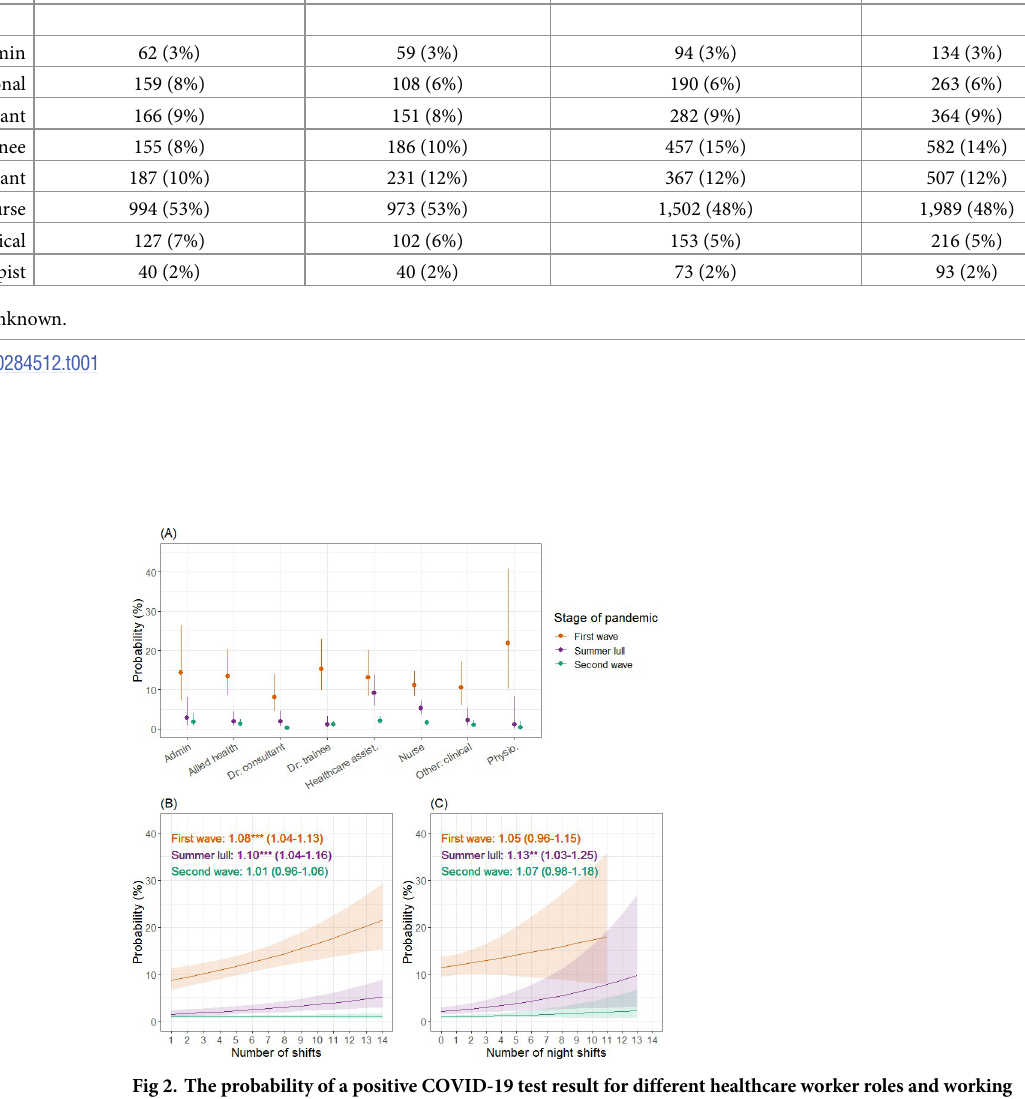
Fig 2. The probability of a positive COVID-19 test result for different healthcare worker roles and working patterns during the first year of the COVID-19 pandemic. Estimates (and 95% confidence intervals) are plotted from a mixed effects logistic regression for the first wave (orange), summer lull (purple) and second wave (green). Panel A shows the probability of testing positive for different healthcare worker roles, panel B for the total number of shifts worked two weeks prior to taking a COVID-19 test, and panel C for the relative number of night shifts worked. For plots B & C, the estimated odds ratio, 95% confidence interval and statistical significance (as indicated by asterisks; * p < 0.05; ** p < 0.01; *** p < 0.001) are